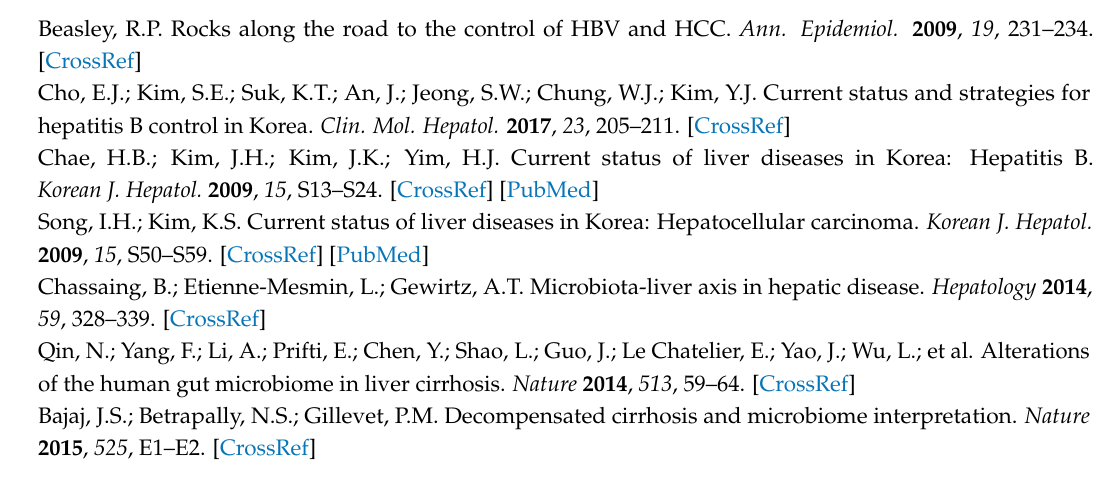
Figure S1: Bar chart of the proportional abundance at phylum and genus levels in three categories. Table S1: Pairwise comparison of alpha diversity by Kruskal-Wallis test. Table S2: Pairwise comparison of beta diversity by PERMANOVA